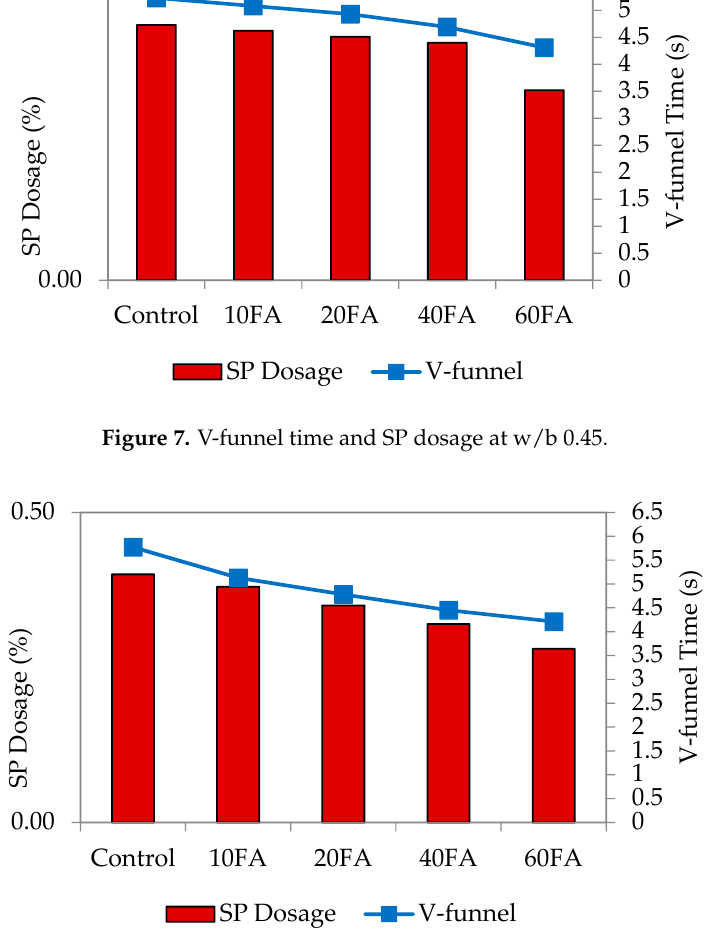
Figure 8. V-funnel time and SP dosage at w/b 0.50.